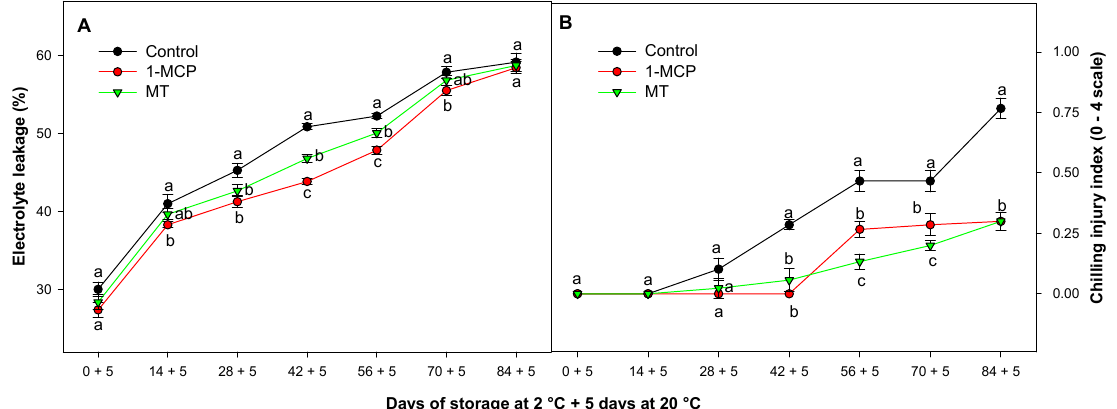
Figure 5. Evolution of electrolyte leakage (%) ( A ) and chilling injury index (0–4 scale) ( B ) of ‘Hayward’ kiwifruit treated with distilled water (Control), 1-MCP at 0.5 µL L − 1 , or melatonin at 0.1 mM (MT) during cold storage plus 5 days at 20 °C. Data are the mean ± SE ( n = 3). Different lowercase letters show significant differences ( p < 0.05) among treatments for each sampling date.